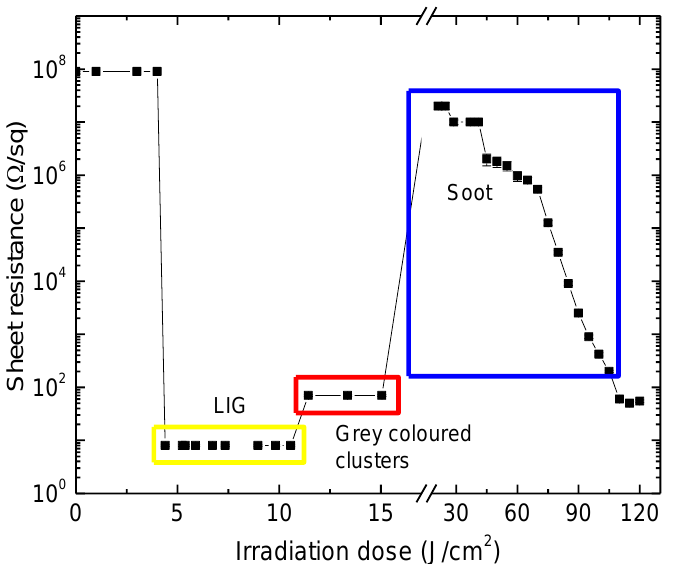
Figure 7. The sheet resistance of laser-treated polyimide surface versus irradiation dose. Irradiation dose was varied only by changing beam diameter on the sample surface. Three different polyimide surface modification regimes were distinguished. Depending on the applied irradiation, dose, soot, graphene (as we suggest LIG) or transitional state were found on the PI surface.